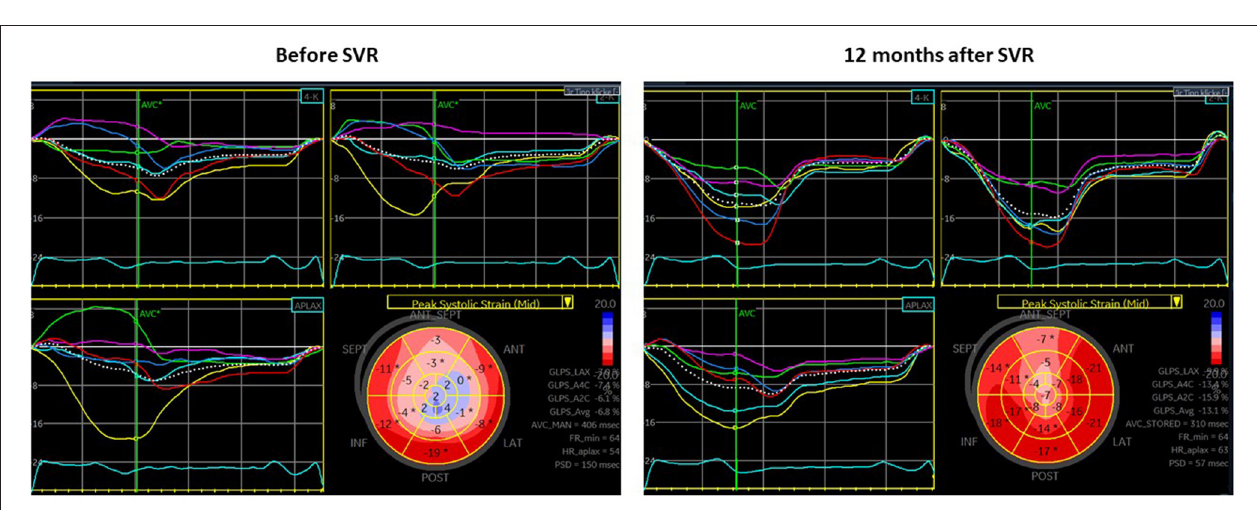
(Figure 4 ). No significant difference in event-free survival according to BLS was found when stratifying patients with other LV